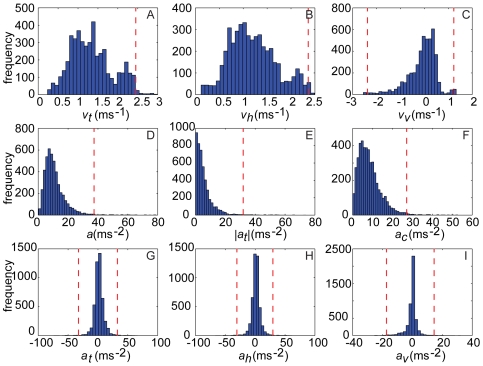
Histograms of translational flight performance.Plots show translational flight performance metrics: (A–C) total speed () and its horizontal () and vertical () components; (D–F) total acceleration (a) and its absolute tangential () and centripetal () components; (G–I) total tangential acceleration and its horizontal () and vertical () components. In each case, the variables plotted in the first column are the Pythagorean sums of the variables plotted in the second and third columns within a row. Dashed lines represent 99% confidence intervals and are one-tailed in the cases where a single line is presented, and two-tailed where two lines are plotted.